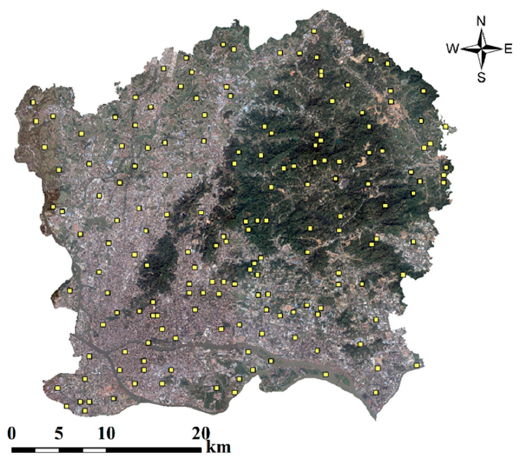
Figure 4. Spatial distribution of the sample areas.